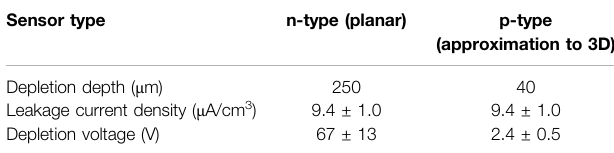
TABLE 1 | Predicted peak leakage current density and fi nal depletion voltage for silicon sensors operating in the Martian environment for a duration of 28.2 Earth-years, including a safety factor of 1.5 applied to current. The 10.5% uncertainty on the leakage current corresponds to contributions from the scale factor fi tandtheprecisionbywhichthetemperatureisknown.Theuncertainty on the depletion voltage, due to uncertainties on the Hamburg Model parameters, is taken to be